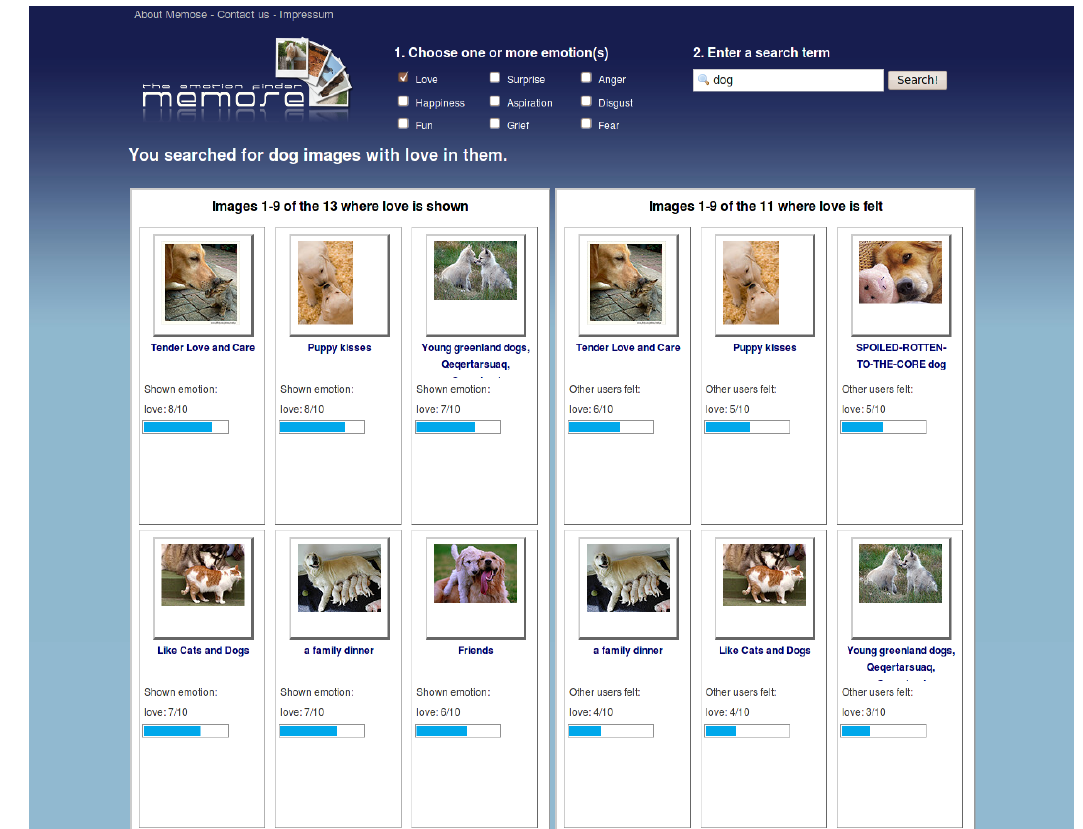
Figure 7. Retrieved results in a table environment in the first version of